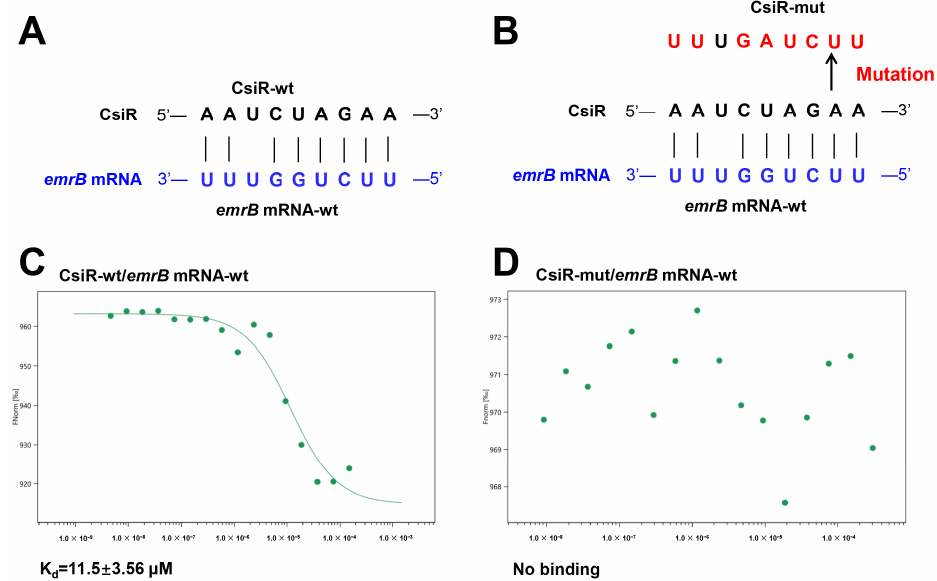
Figure 5. Binding affinity between CsiR and emrB mRNA. ( A , B ) Schematic diagram and binding or mutation of the base-pairing sites between CsiR and emrB mRNA, respectively. The binding sites of emrB mRNA and the mutated sites of CsiR are marked in blue and red, respectively. ( C , D ) Determination of the affinity of CsiR-wt and CsiR-mut binding to emrB mRNA, respectively. Affinity data were obtained from three independent repeated tests ( n = 3).